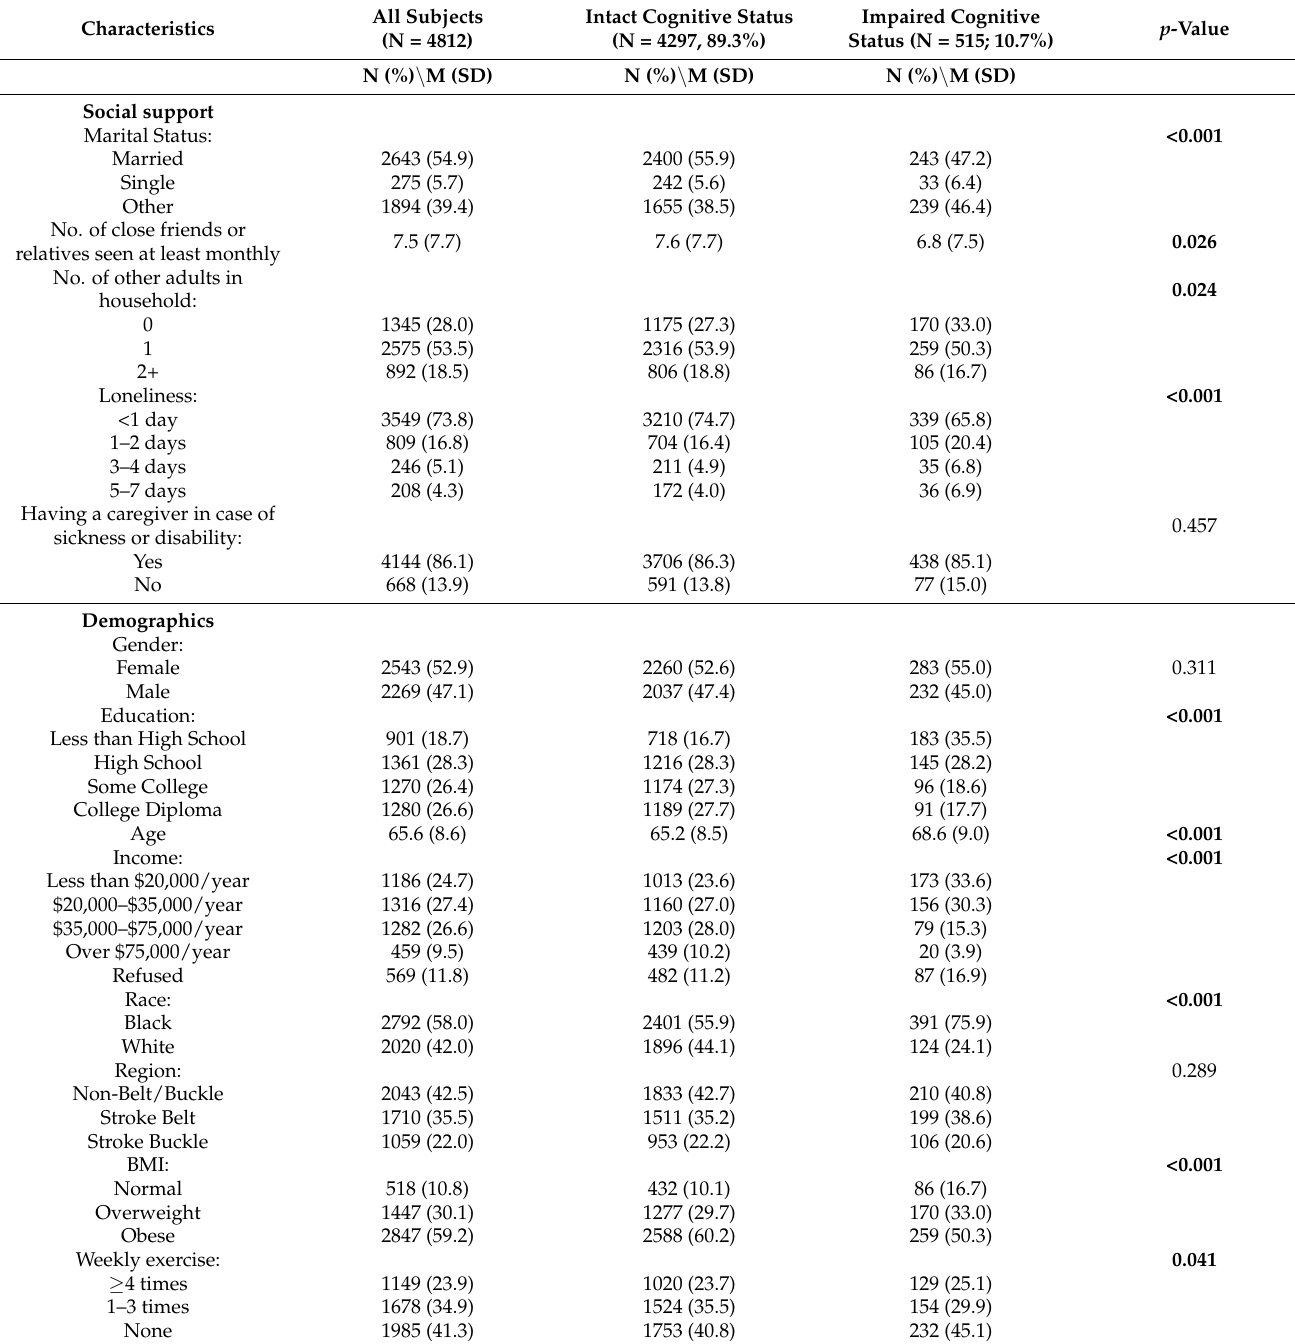
Table 1. Sample characteristics overall and by cognitive status among REGARDS